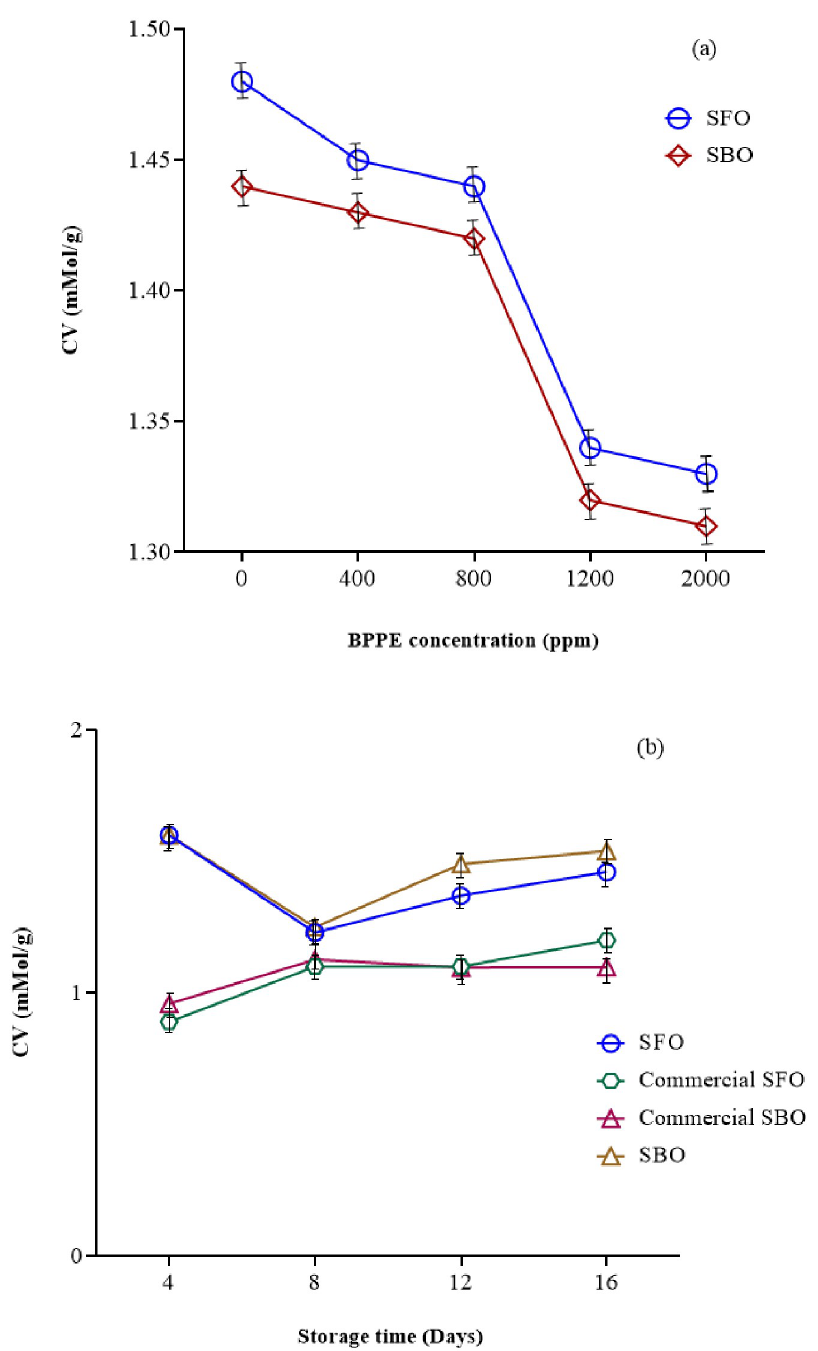
Fig 6. The effect of a) BPPE concentration � and b) storage time �� on CV of SBO and SFO. (BPPE: Black plum peel extract, Soy: Soybean oil, Sun: Sunflower oil, CSoy: Commercial soybean oil, CSun: Commercial sunflower oil) � (P � 0.05), �� (P >